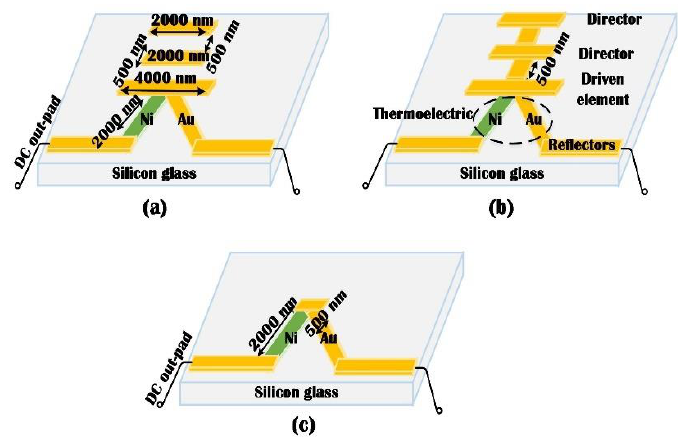
Figure 2. Proposed nanoantenna designs for this work: ( a ) Traditional Yagi–Uda, ( b ) quasi-Yagi– Uda, and ( c ) nano-thermoelectric junction. and ( c ) nano-thermoelectric